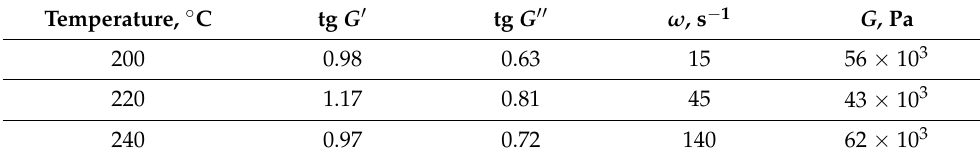
Table 2. Viscoelastic behavior of 60 Al 2 O 3 /40PLAcomposition.